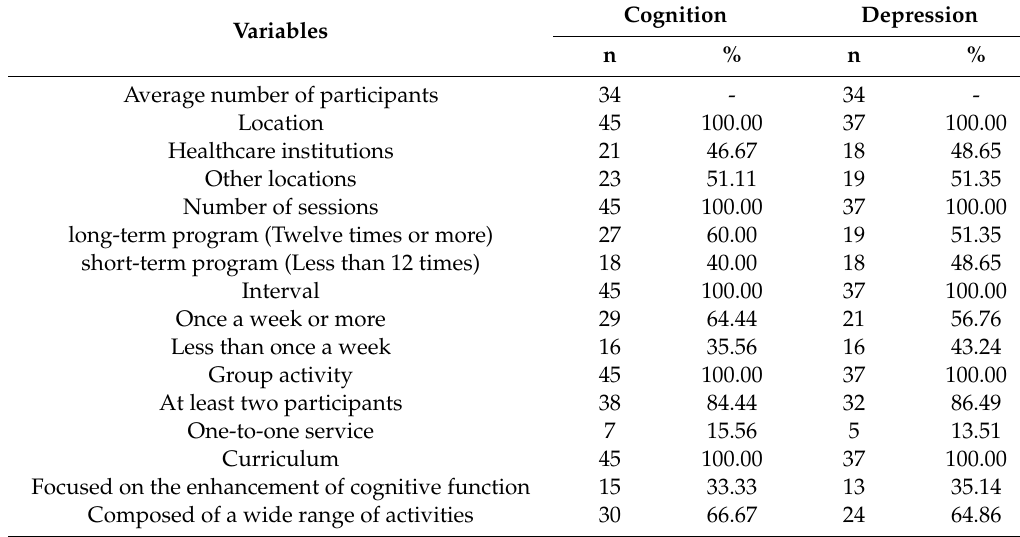
Table 1. Descriptive statistics of the programs on cognition and